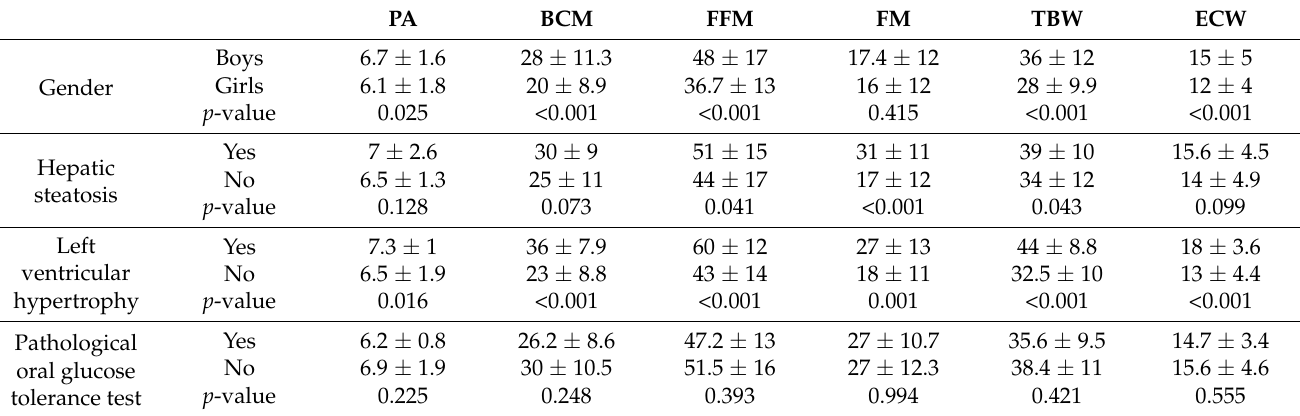
Table 3. The independent samples t-test results presented as mean ± standard deviation and p -value; PA—phase angle, BCM—body cell mass, FFM—fat-free mass, FM—fat mass, TBW—total body water, ECW—extracellular